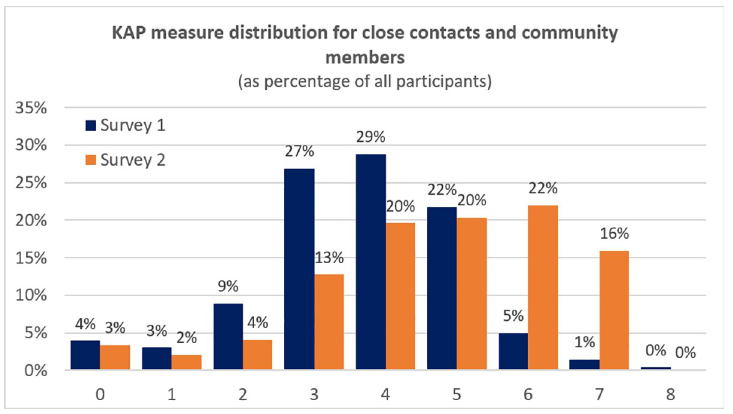
Fig 2. Distribution of the KAP measure scores for close contacts and community members in Survey 1 and Survey